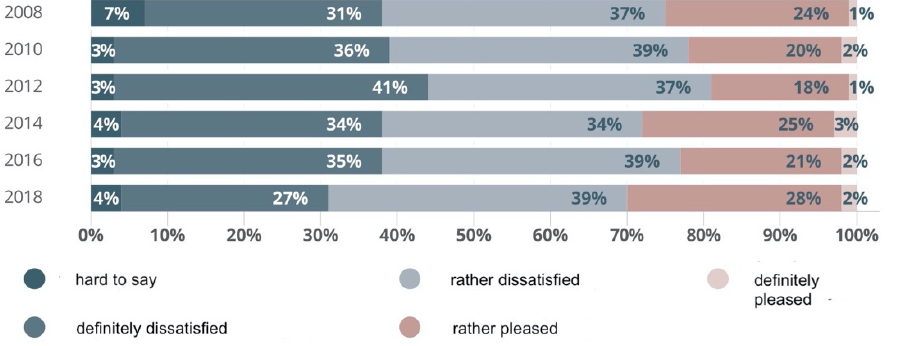
Figure 3. Level of satisfaction from healthcare system in Poland. Prepared by: A. Gawlak, on the basis of the data published by the Polish Supreme Chamber of Control and Centre for Public Opinion Research (Communication no. 89/2018).